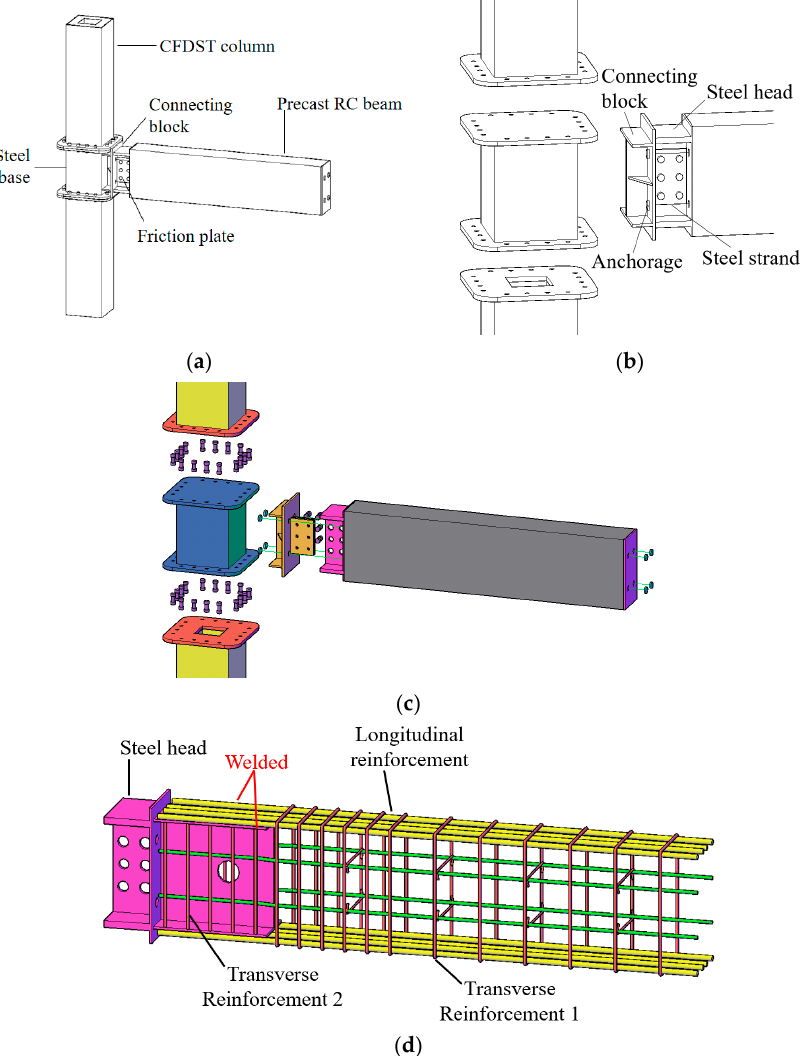
Figure 1. Self-centering joints between CFDST columns and RC beams: ( a ) Overall assembly of the joint; ( b ) Joint details; ( c ) Explosion of the joint; ( d ) Arrangement of steel components in the beam.